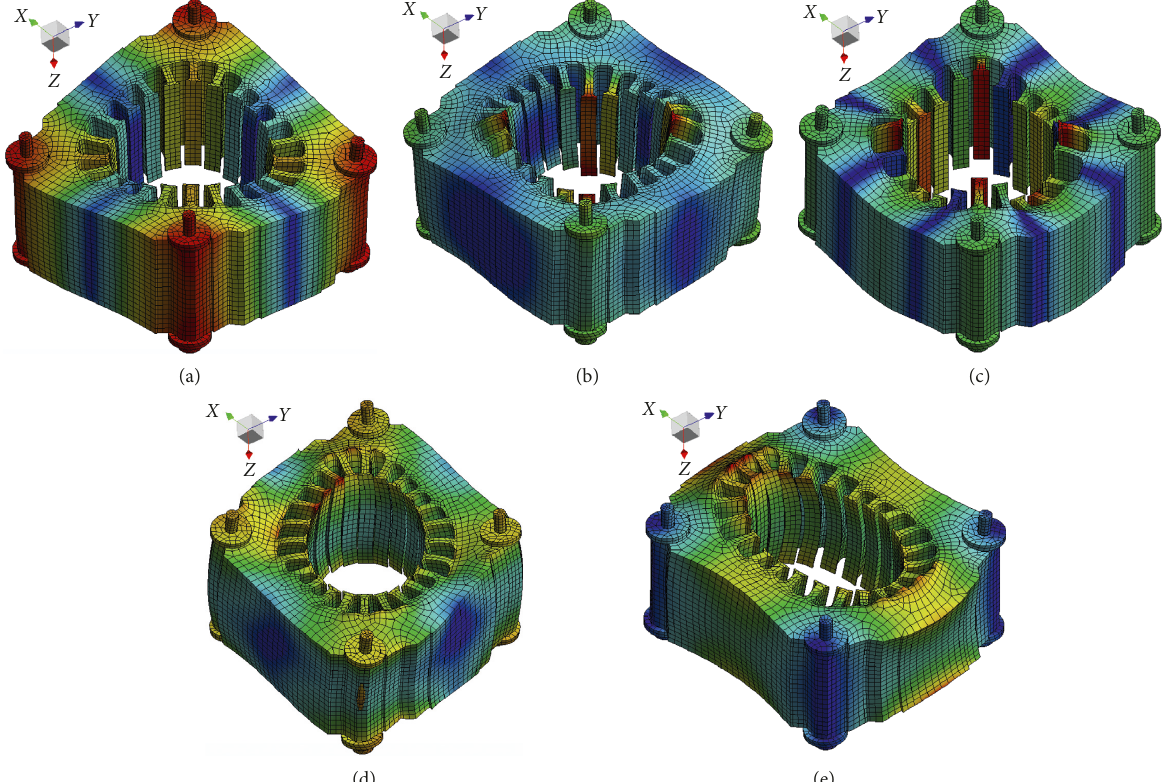
Figure 21: Numerical modal shapes of the stator model with absence of winding: (a) ω N : 1136.9Hz; (b) ω N : 2619.7Hz; (c) ω N : 2267.3Hz; (d) ω N : 3656.5Hz; (e) ω N :